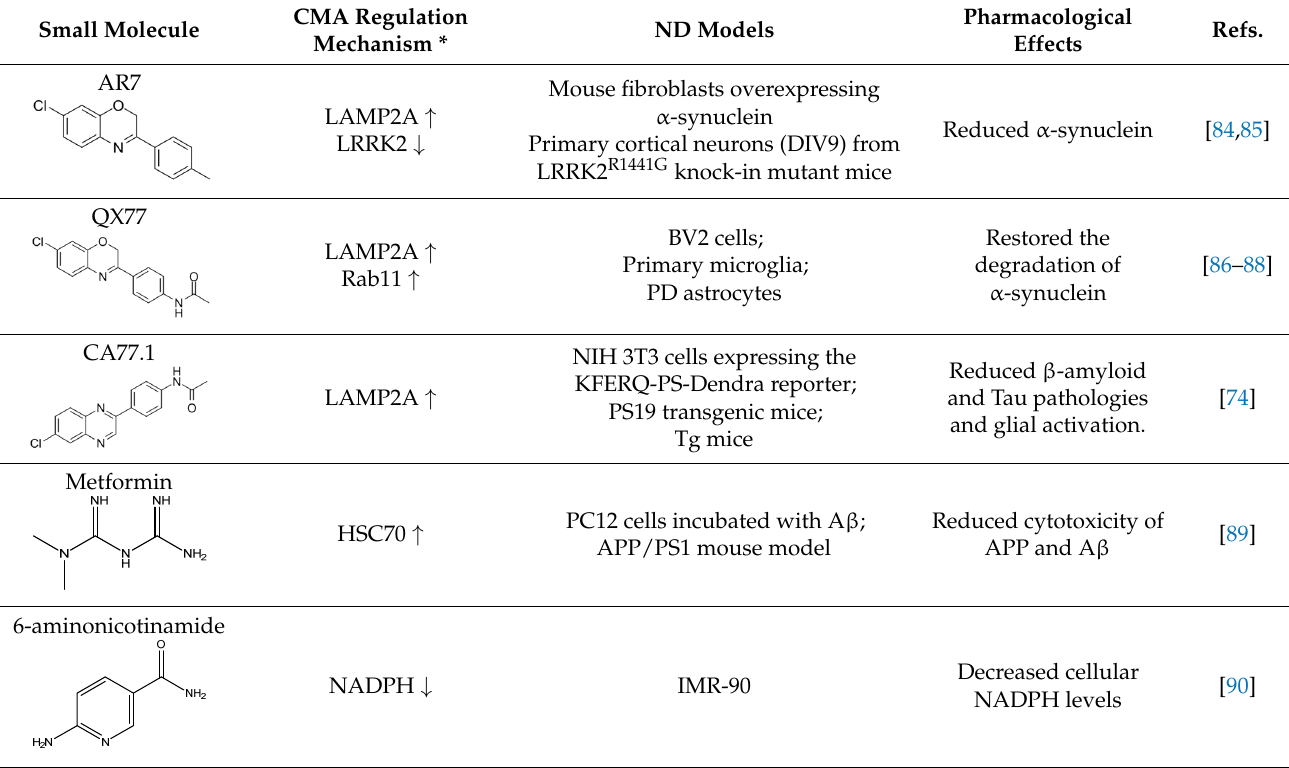
Table 1. Chaperone-mediated autophagy (CMA)-inducing small molecules and their pharmacological effects in neurodegenerative disease (ND).